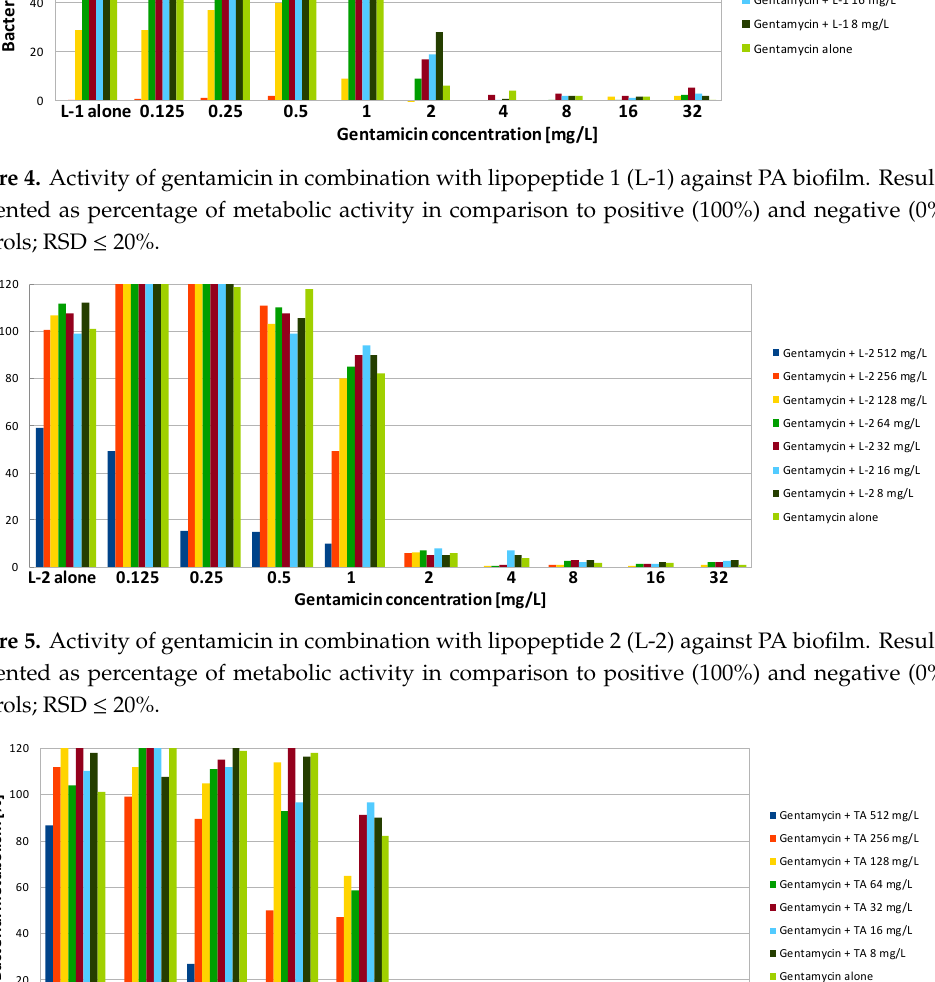
Figure 6. Activity of gentamicin in combination with temporin A (TA) against PA biofilm. Results presented as percentage of metabolic activity in comparison to positive (100%) and negative (0%) controls; RSD ≤ 20%.